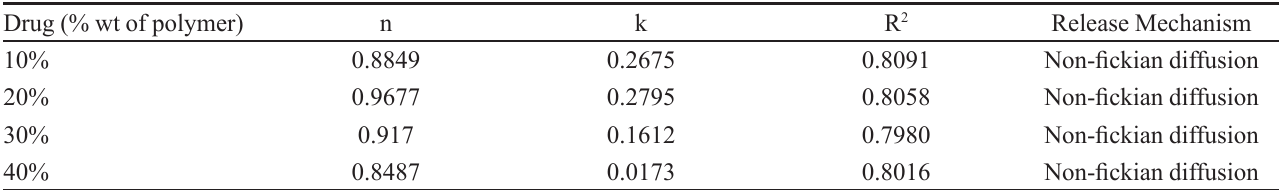
TABLE III - Fittings of release profiles to Korsemeyer-Peppas semi-empirical model Drug (% wt of